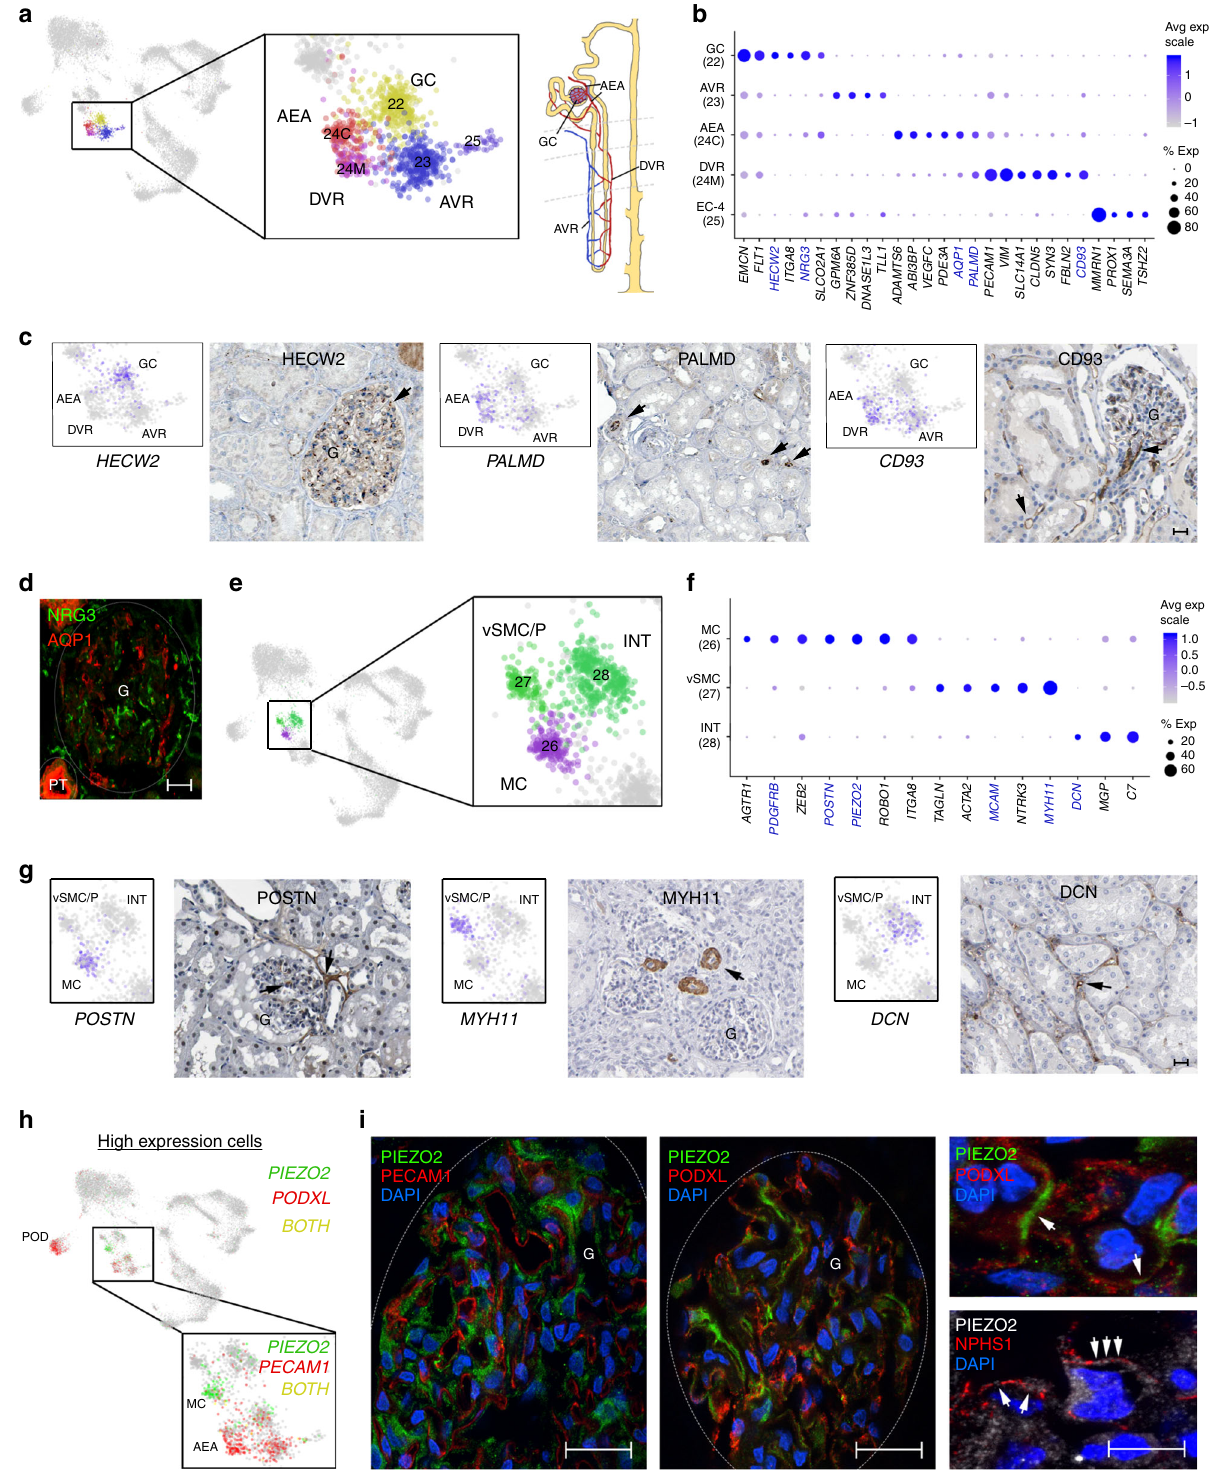
validated hypertension locus 22 , providing a possible link between responses to mechanical changes due to variations in blood pressure, glomerular fi ltration and kidney failure. The diversity of integrin expression provides further insights into the potential ligand interactions for speci fi c kidney cells that may serve as a benchmark for understanding disease pathologies. Therefore, our pipeline allows for highly detailed molecular characterization of